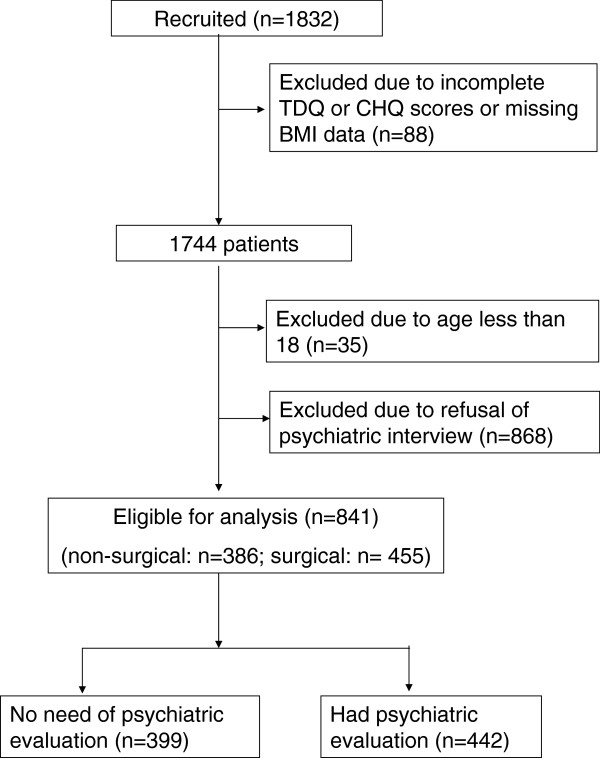
Flow of the study.